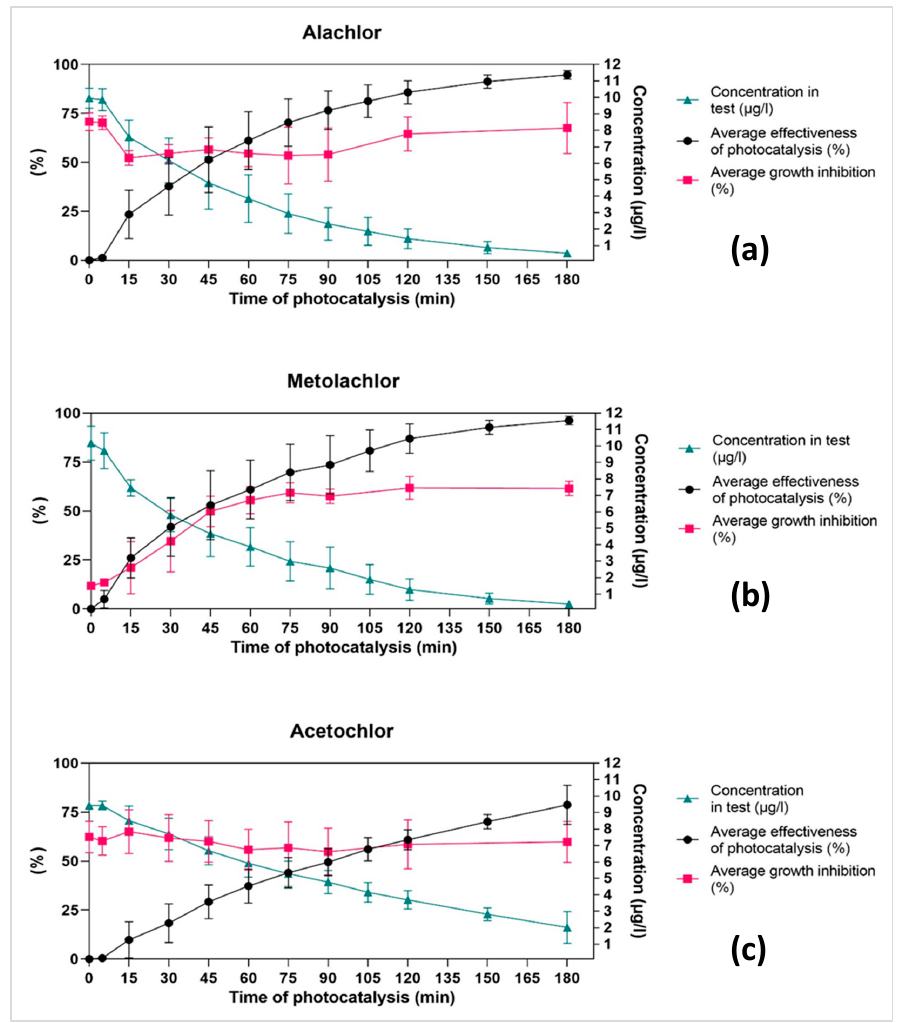
Figure 3. The average growth inhibition (%) of Chlorella kessleri exposed to a mixture of herbicides and their photocatalytic degradation products collected at a different time of photocatalysis (a point at the time of 5 min represents the time of contact of the photocatalyst with herbicides, but without irradiation) in comparison with the average effectiveness of photocatalysis and concentration of herbicides in tests (right axis): ( a ) alachlor, ( b ) metolachlor, ( c ) acetochlor.